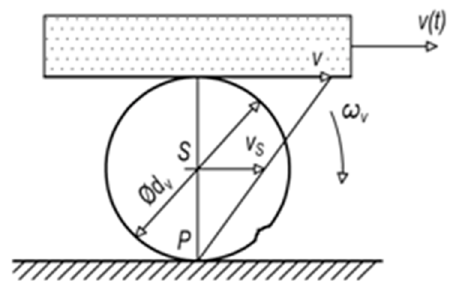
Figure 12. The kinematic scheme—the damage of the rolling element.